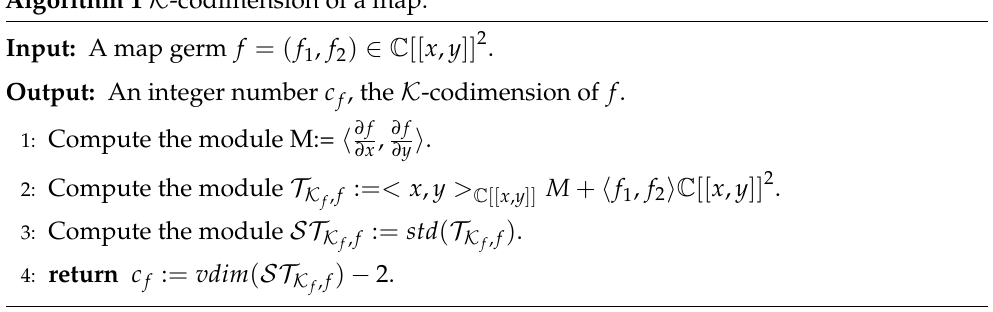
Algorithm 1 K -codimension of a